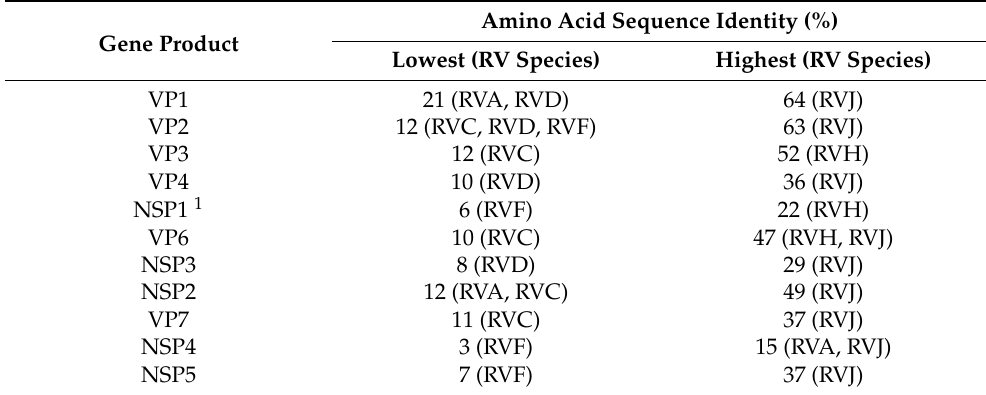
Table 1. Deduced amino acid sequence identities of RVL strain KS14/0241 with the reference strains of other rotavirus species (as specified in Supplementary Data S1). Gene